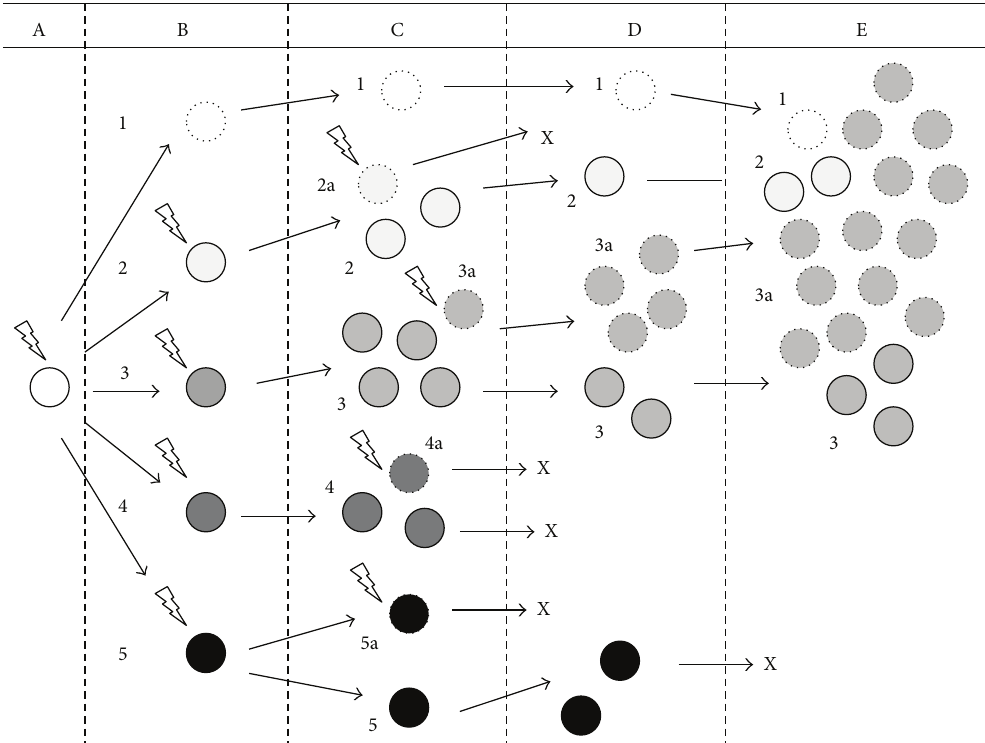
Figure1:Simplifiedschematicsofclonalevolutioninleukemia.Accordingto“clonalevolutionarytheory,”soonaftertheinitialleukemogenic event (here represented by a “lightning bolt”), that is, a first “class-2” mutation leading to expansion of a preleukemic clone (A), additional genetic mutations (again represented by “lightning bolts”) accumulate inside the cell population (B), creating a heterogeneous environment in which several distinct subclones compete for dominance (C). These subclones may later expand or spontaneously disappear (as here subclones 2a, 4, 4a, 5, and 5a do; clonal disappearance is marked by “X”) as a consequence of the selective pressure by intrinsic and extrinsic determinants (D). After the acquisition of “class-1” mutations, overt leukemia arises to clinical diagnosis (E) consisting of a dominant clone (3a in the Figure) and various subclones (1, 2, and